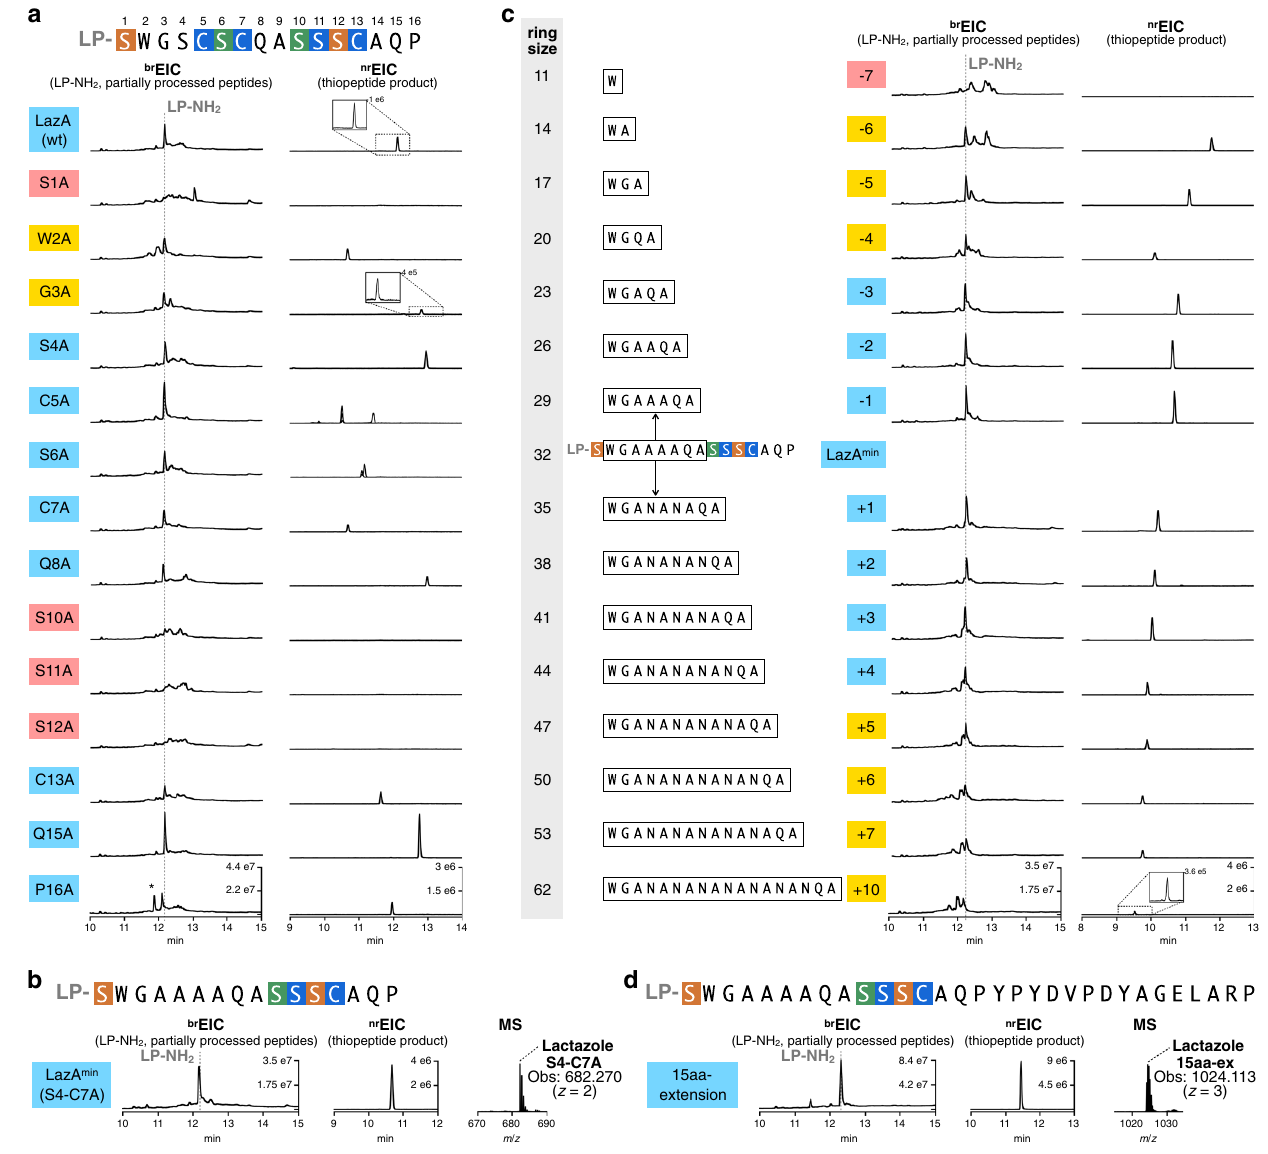
Fig. 3 Substrate scope of the FIT-Laz system. a Ala scanning of the LazA CP. Single-point Ala mutants of LazA were treated with the full enzyme set and the outcomes were analyzed by LC-MS. Displayed are LC-MS chromatograms ( br EIC chromatograms on the left showing partially processed linear peptides and LP-NH 2 after enzymatic treatment, and nr EIC chromatograms on the right for expected thiopeptides generated at m / z 0.10 tolerance window). For mutants highlighted in light blue biosynthesis proceeded ef fi ciently; yellow highlighting indicates inef fi cient thiopeptide formation accompanied by the accumulation of linear intermediates and side products; red indicates mutants that failed to yield a detectable thiopeptide. Peaks denoted with an asterisk (*) indicate translation side products. Mutants C5A and S6A gave 4 and 2 thiopeptides, respectively, annotations of which can be found in Supplementary Figs. 16 and 17. Y-axes are scaled between samples for each chromatogram type. b LC-MS chromatograms as in a for the enzymatic processing of LazA min on the left with a zoomed-in mass spectrum of the produced thiopeptide on the right. c LC-MS chromatograms as in a for ring expansion and contraction study of LazA min . d LC-MS chromatograms and mass spectrum as in b for a LazA min variant containing a 15-amino acid extension in the tail region. Collectively, these data point to remarkable substrate tolerance of Laz (Fig. 3a). Only four Ala mutants, S1A, S10A, S11A, and S12A, that the stepwise enzyme treatment led to Ser10-lactazole, these abolished the formation of thiopeptides, whereas other constructs results suggest that the minimal recognition motif around the 4 π led to corresponding lactazole analogs and LP-NH 2 . During component for the LazC-catalyzed macrocyclization may be as maturation, Ser1 and Ser12 are converted to Dha and are then small as oxazole11-Dha12. Signi fi cant accumulation of linear side utilized by LazC for pyridine formation/macrocyclization. products and partially processed peptides for W2A and G3A Moreover, pyridine synthases are known to recognize the mod- mutants indicates that these amino acids are also important for i fi cation pattern around the 4 π component 35 , which is consistent smooth lactazole biosynthesis. Ala mutants in positions 4 – 8, 15, with the abrogation of biosynthesis in S10A and S11A mutants. and 16, including those disrupting azole and Dha installation, On the other hand, C13A mutant was converted to a thiopeptide were tolerated, albeit in some cases a mixture of thiopeptides without modi fi cations in the tail region. Combined with the fact formed (Supplementary Figs. 16 and 17).